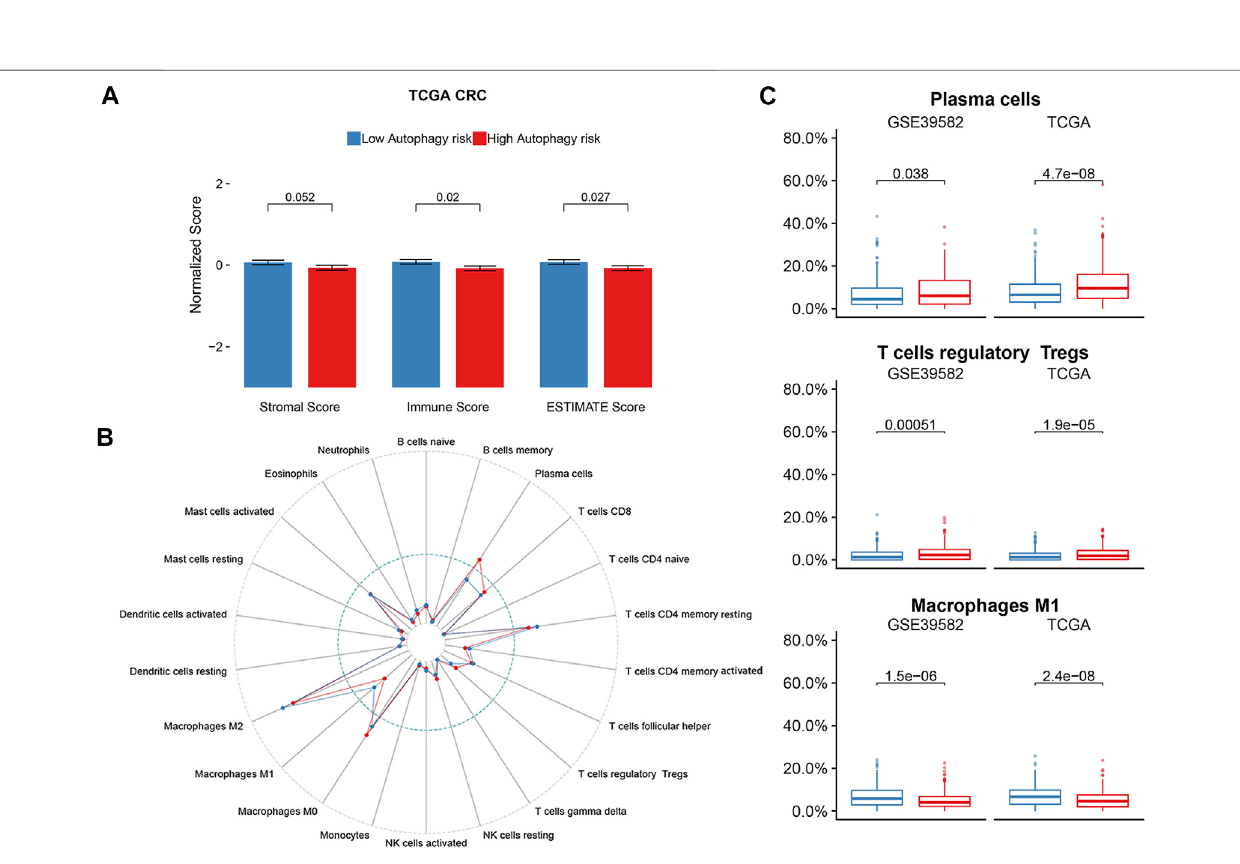
Frontiers in Genetics |